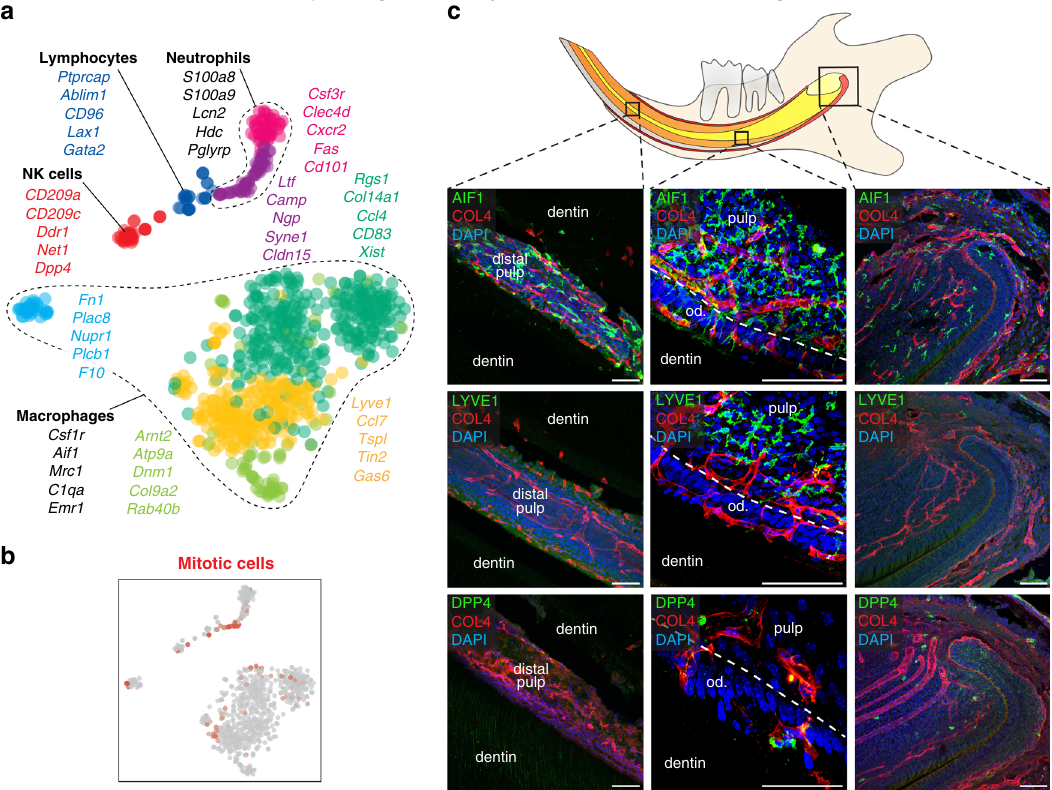
Fig. 10 Heterogeneity of immune cells in mouse incisor. a t-SNE dimensional reduction shows ten identi fi ed populations of immune cells. b Position of mitotic cells in the immune cluster. c Location of tissue-residential immune cells in the different parts of mouse incisor. AIF1 + macrophages are located in the whole incisor including apical pulp, cervical loop, odontoblast layer, and distal pulp in contrast to LYVE + macrophages which mostly resides in the middle part of the pulp, but not inside the odontoblast layer. DPP4 + immune cells are sporadically located in the apical part of the tooth and odontoblast layer. COL4 immunohistochemical staining visualize the blood vessels. (Od. Odontoblasts), Scale bars: 50 µ